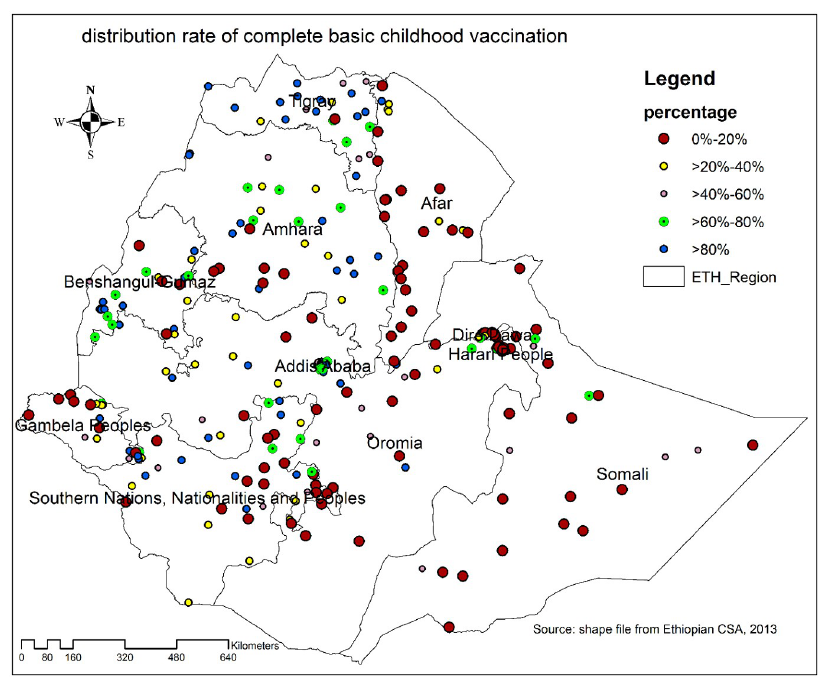
Fig 2. Spatial distribution of complete basic childhood vaccination among children aged 12–23 months across regions of Ethiopia, EMDHS 2019.